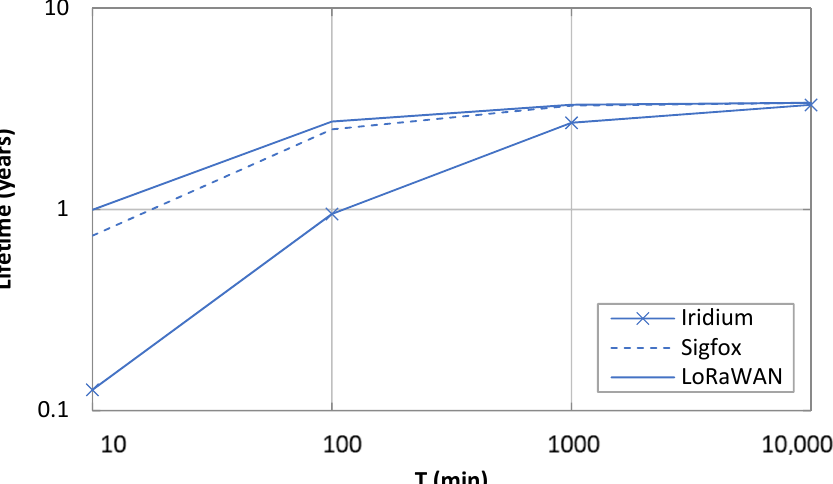
Figure 11. Lifetime of a device running on a 2400 mAh battery for Iridium, Sigfox. and LoRaWAN, as a function of T and for p = 0.